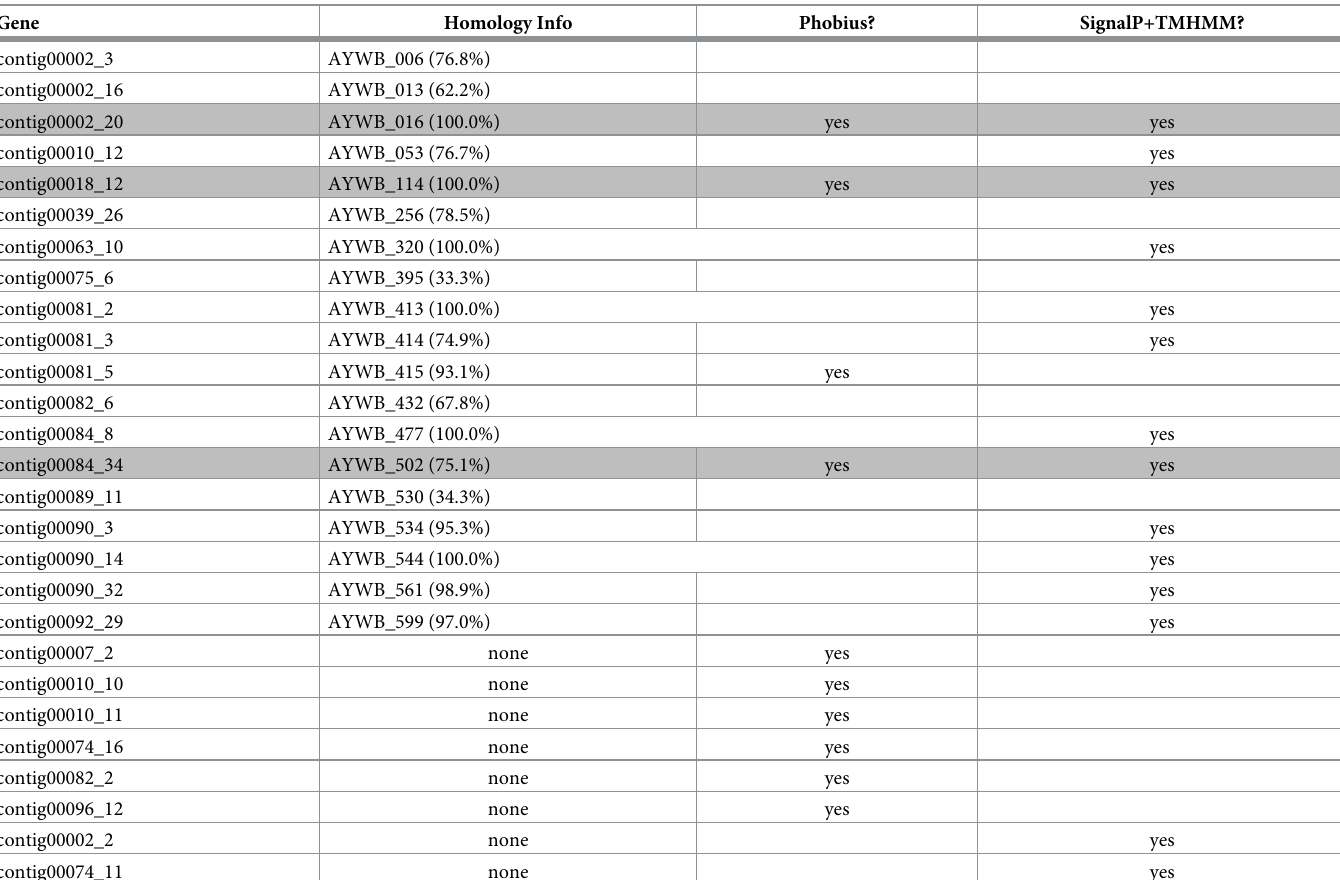
Table 4. Candidate cell wall membrane-anchored, secreted proteins in NJAY. Gene Homology